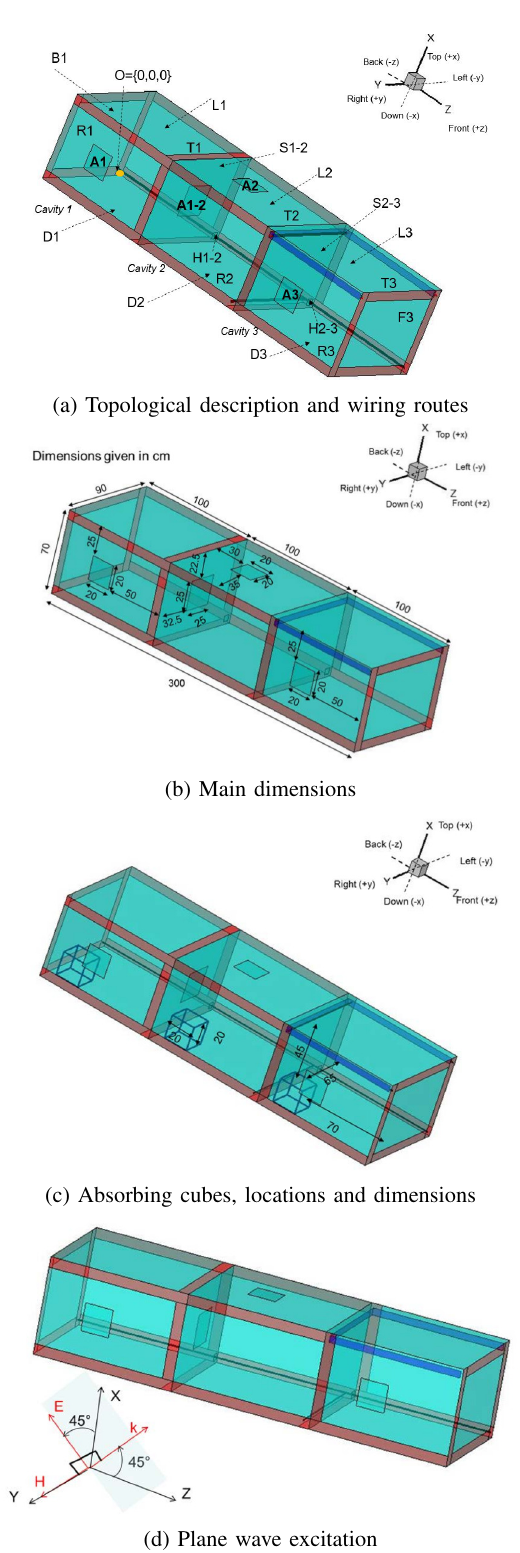
FIGURE 1: 3D-structure problem geometry, absorbing ele- ments, dimensions and source excitation.